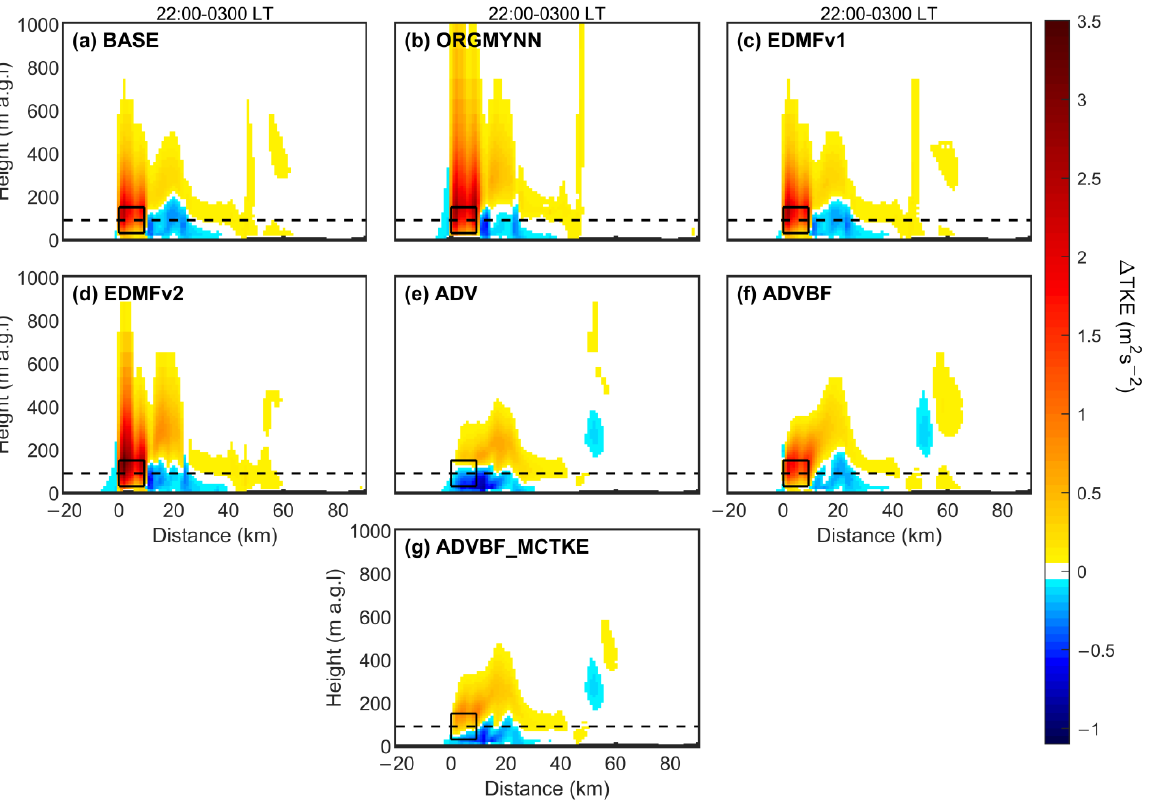
Figure 8. Wind farm wake impact on TKE from a vertical cross-section for the simulations of ( a – g ) BASE, ORGMYNN, EDMFv1,EDMFv2, ADV, ADVBF and ADVBF_MCTKE. Box represents the rotor area of the wind farm. The dashed horizontal line represents the hub height of the wind